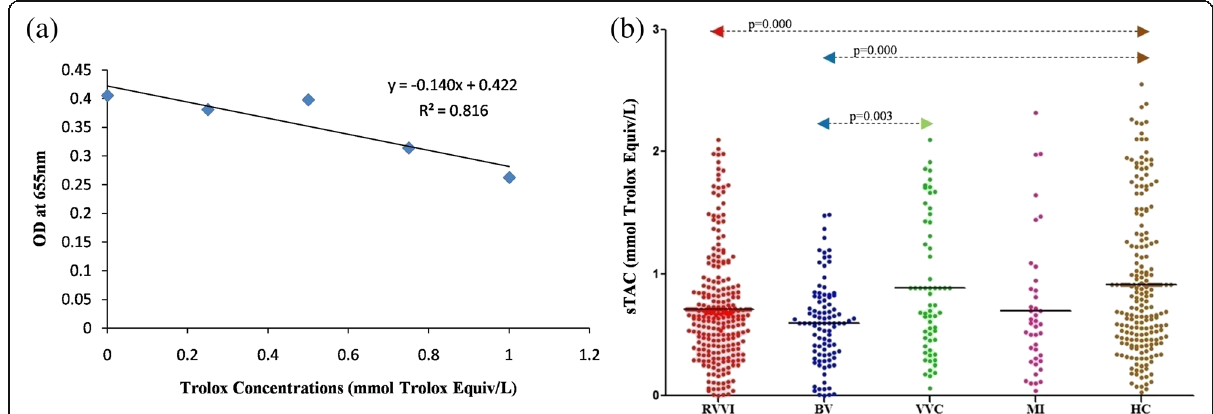
Fig. 1 a Standard curve for quantitative evaluation of sTAC. b sTAC in different clinical categories of RVVI and healthy controls (HC). Dot plot presenting the distribution of sTAC in patients and controls. Horizontal line signifies the mean value